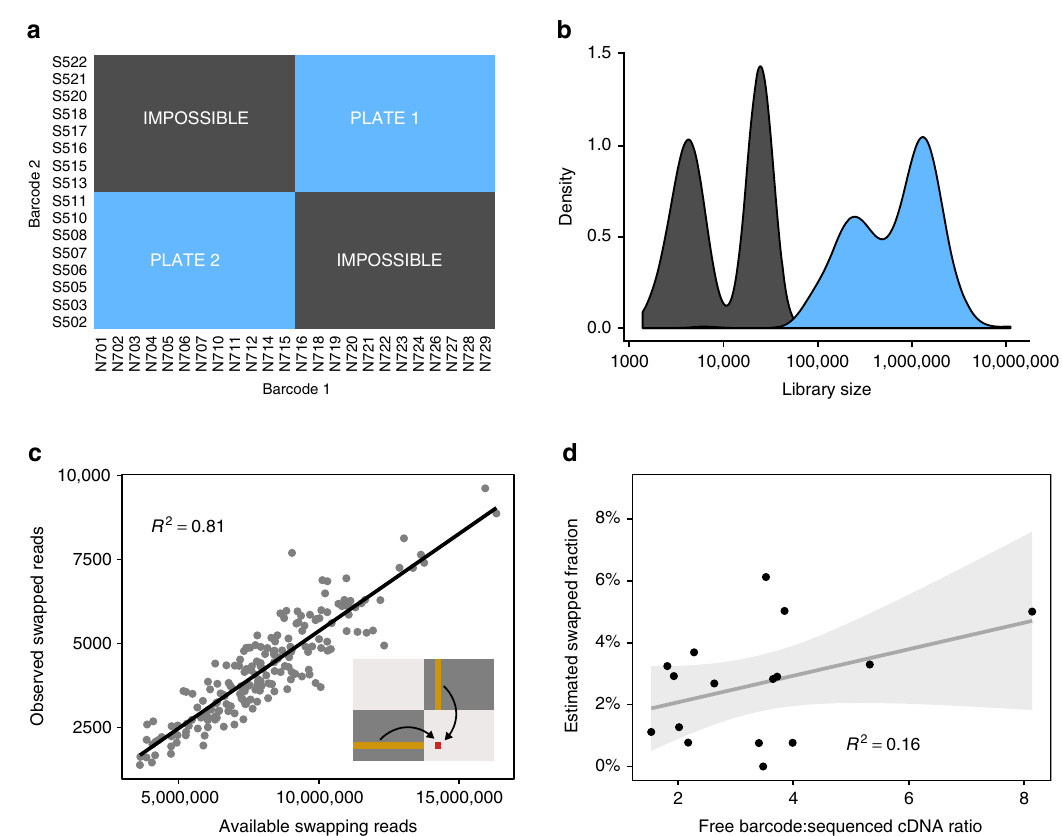
Fig. 2 Characterization of barcode swapping in plate-based scRNA-seq experiments. a The experimental design of the Richard dataset. Two 96-well plates of cells were multiplexed for sequencing. Expected barcode combinations are marked in blue, while impossible barcode combinations are marked in grey. b Distribution of the library sizes (i.e., number of mapped reads) in the expected and impossible barcode combinations. c Library size of each impossible combination (observed swapped reads), plotted against the sum of the library sizes of the expected combinations that share exactly one barcode with that impossible combination (available swapping reads). An example is illustrated graphically in the inset Figure for one impossible combination (red) and the contributing expected combinations (orange). The gradient represents the fraction of available reads from the expected combinations that swap into each impossible combination. d Estimated swapping fractions for different plates of the Nestorowa et al. [10] dataset, plotted against the ratio of the concentration of free barcode to the concentration of cDNA of the correct length for sequencing. A linear regression fi t is shown with its 95% con fi dence interval. The slope of the fi tted line is not signi fi cantly different from 0 ( p =